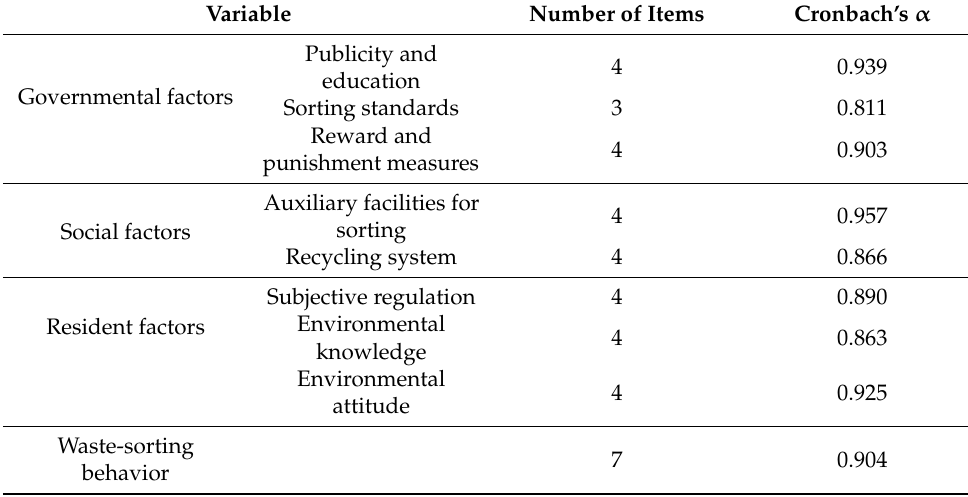
Table 11. Results of confidence analysis.